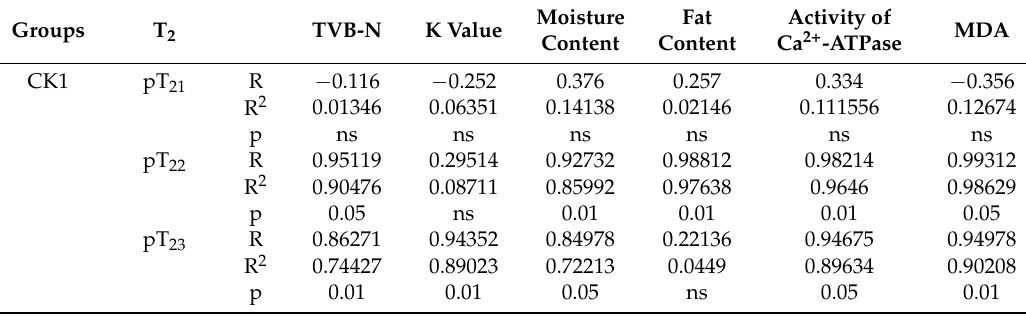
Table 2. Linear regression analysis of HTS fillets with different treatment during refrigerated storage. Groups T 2 TVB-N K